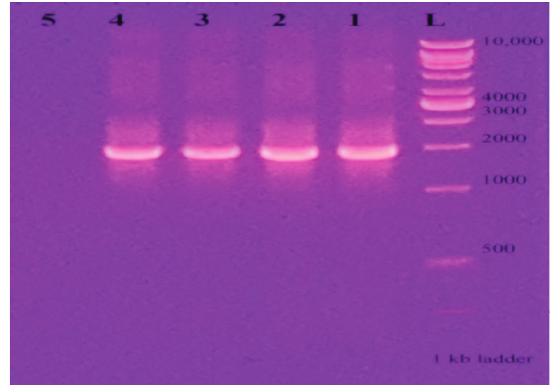
Figure 5: DNA bands visualized on agarose gel electrophoresis. Figure